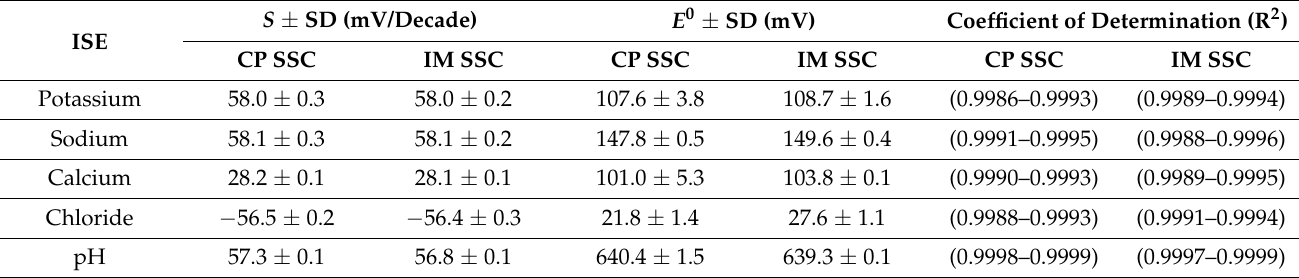
Table 1. Calibration curve parameters obtained for commercial ISEs using SSC reference electrodes. The reported values are the mean from three identical electrodes ± standard deviation (SD), and the goodness of fit represented by coefficient of determination (R 2